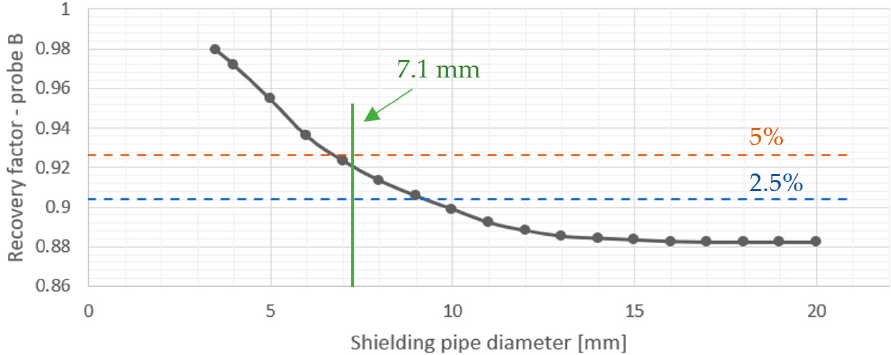
Figure 4. The dependence of the recovery factor on the probe B shield diameter; CFD simulation results.